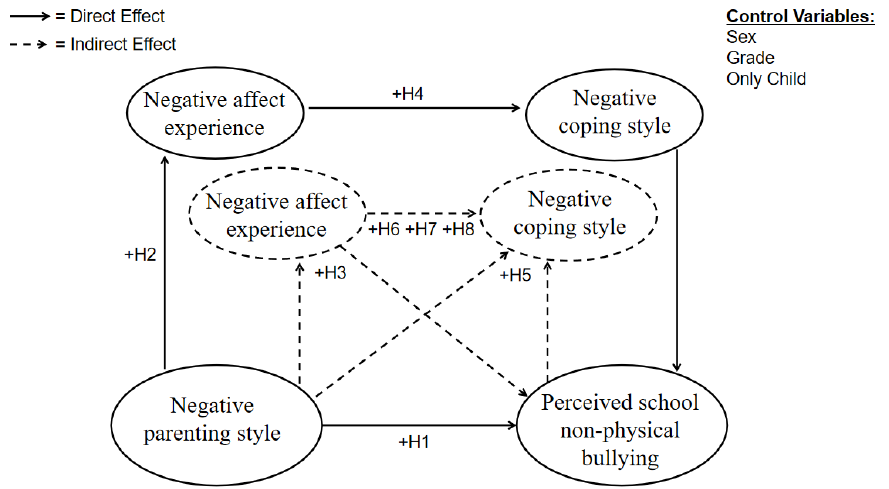
Figure 1. Hypothesized model.